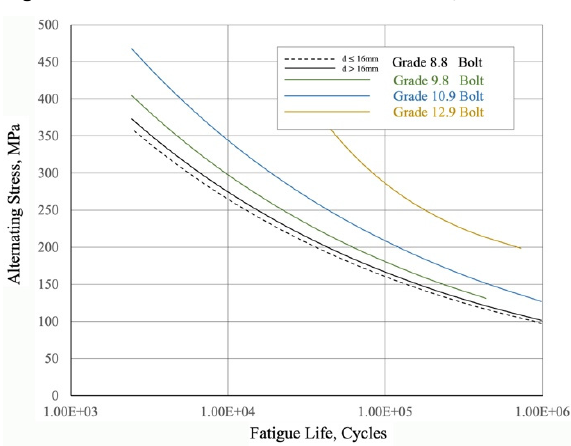
Figure 4. S-N curves for stress concentration K t = 4.89